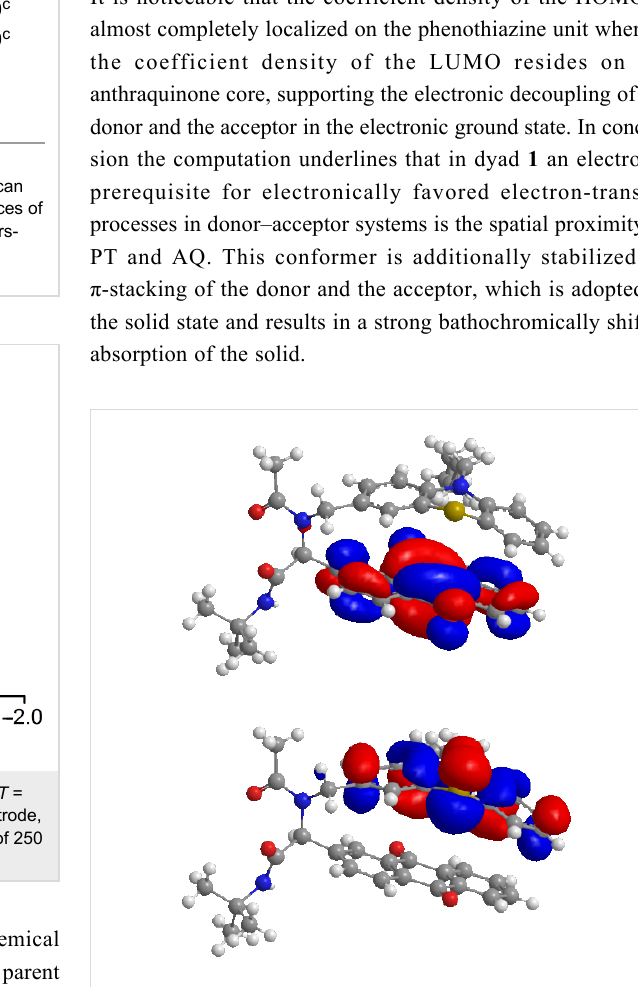
Figure 4: DFT-computed (B3LYP, 6-311G*) frontier molecular orbitals HOMO (bottom) and LUMO (top) of the phenothiazine–anthraquinone dyad 1